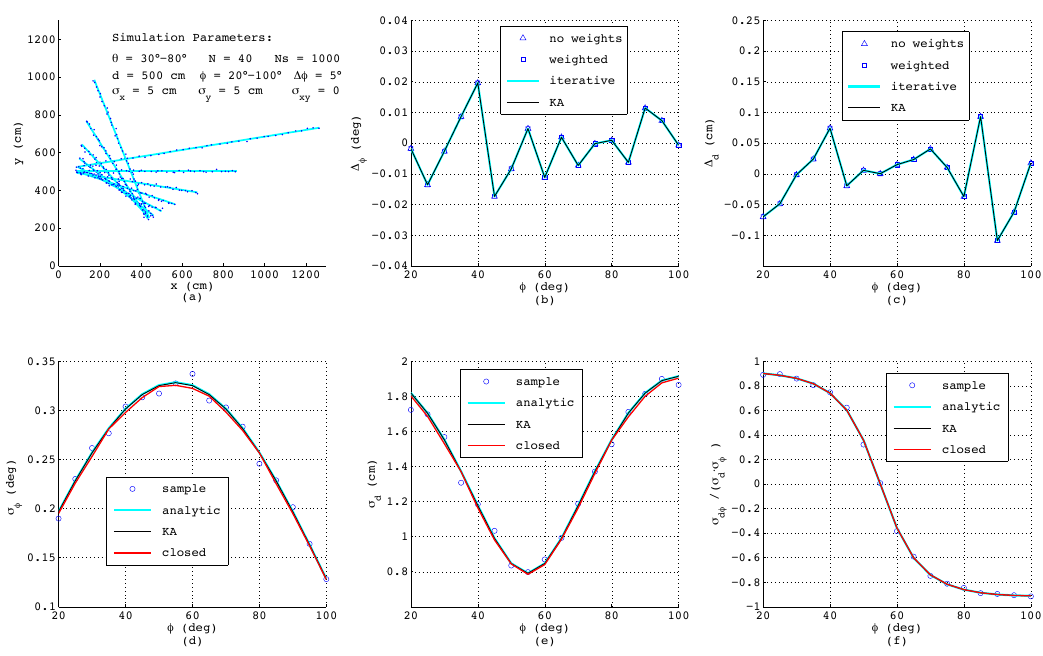
Figure 5. Simulation results for equidistant measurement points superimposing normally-distributed and uncorrelated noise in the x - and y